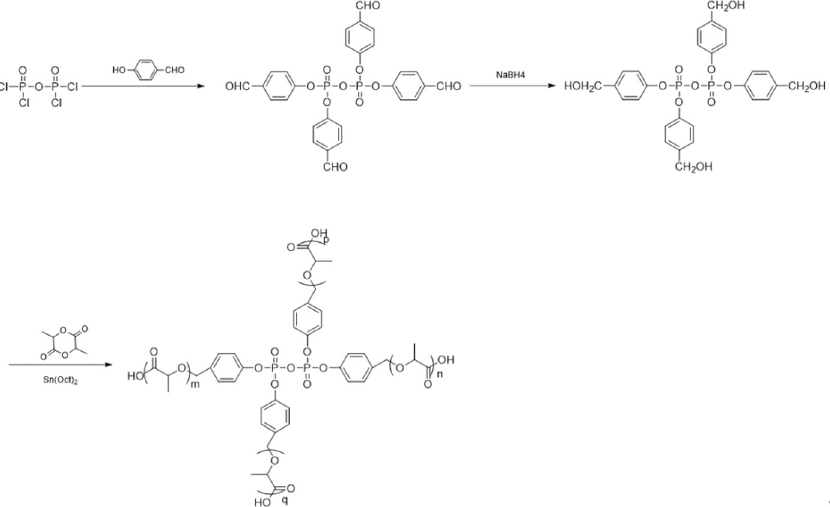
Figure 1. Plugging agent synthesis reactor.